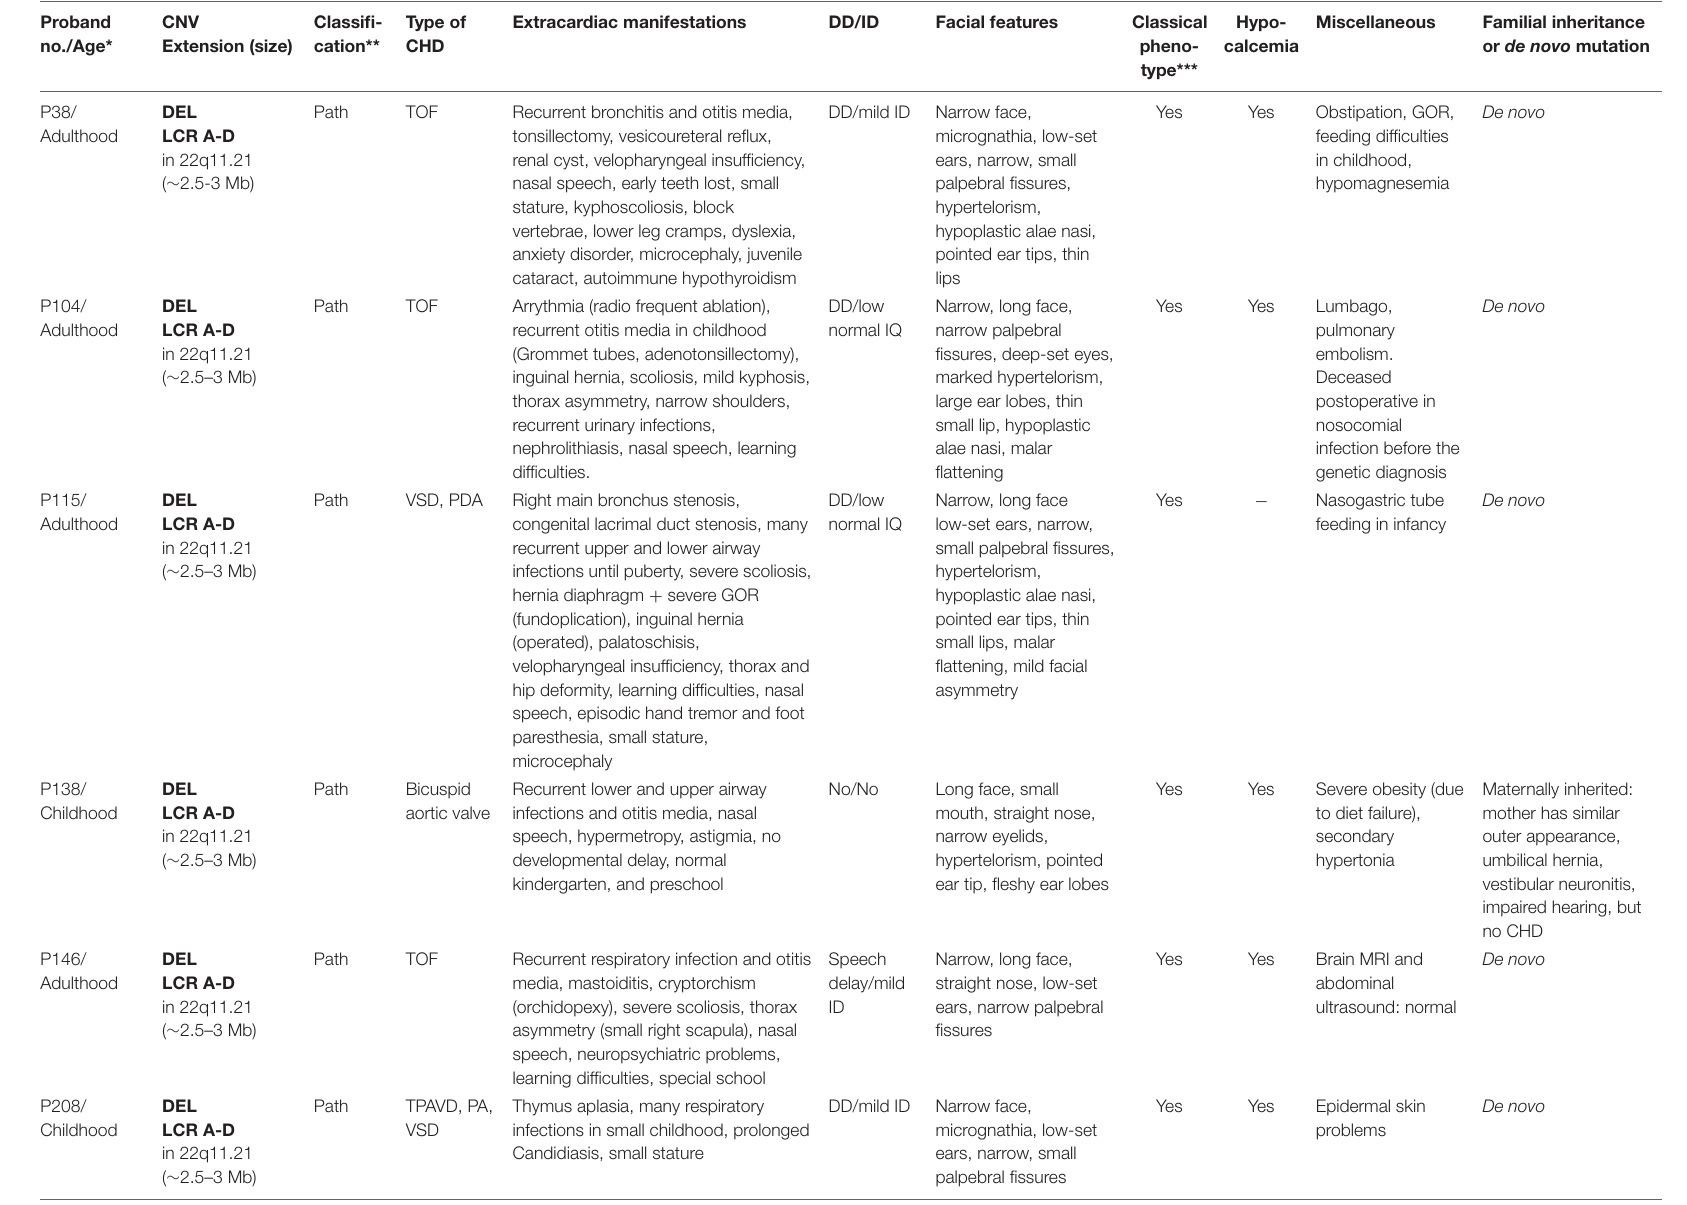
TABLE 3 | Clinical features of probands and parents with pathogenic and VUS MLPA results. Proband